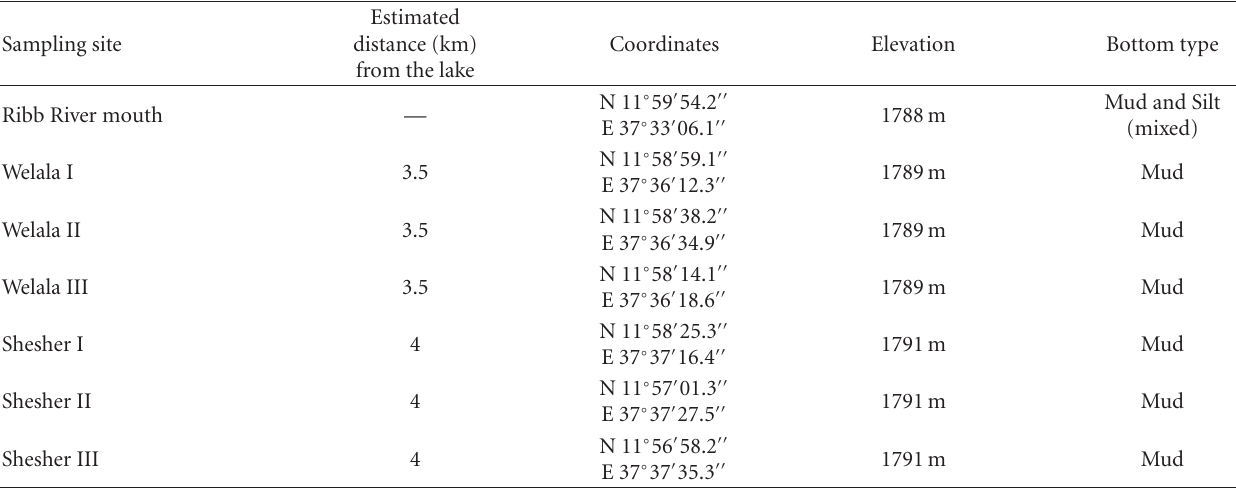
Table 1: Sampling sites, estimated distance from the lake, coordinates, elevation, and bottom types of the sampling sites. Sampling